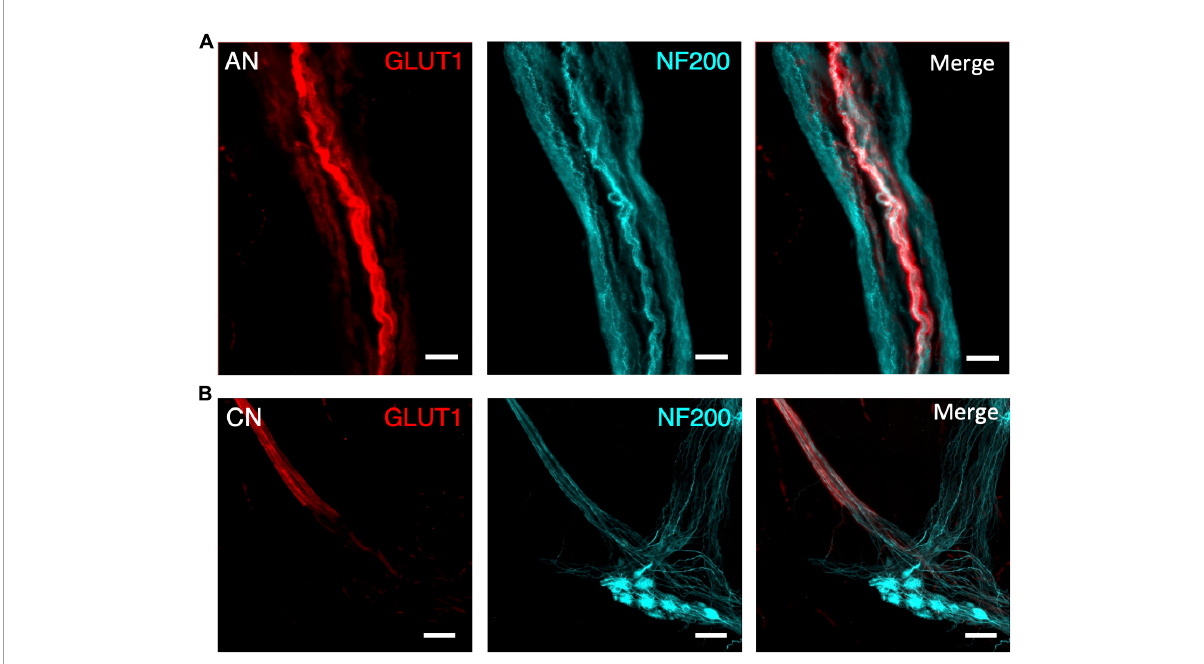
FIGURE4 Comparison of an ascending nerve (AN) (A) and colonic nerve (CN) (B) in the bowel wall of the same sigmoid colon specimen, labelled for glucose transporter 1 (GLUT1; red) and neurofilament-H (NF200, cyan). Both nerve bundles are surrounded with a GLUT1-immunoreactive sheath, however, the ascending nerve runs the full length of the image. In comparison, the colonic nerve loses its GLUT1 labelling when its axons enter a myenteric ganglion. All scale bars = 100 µ